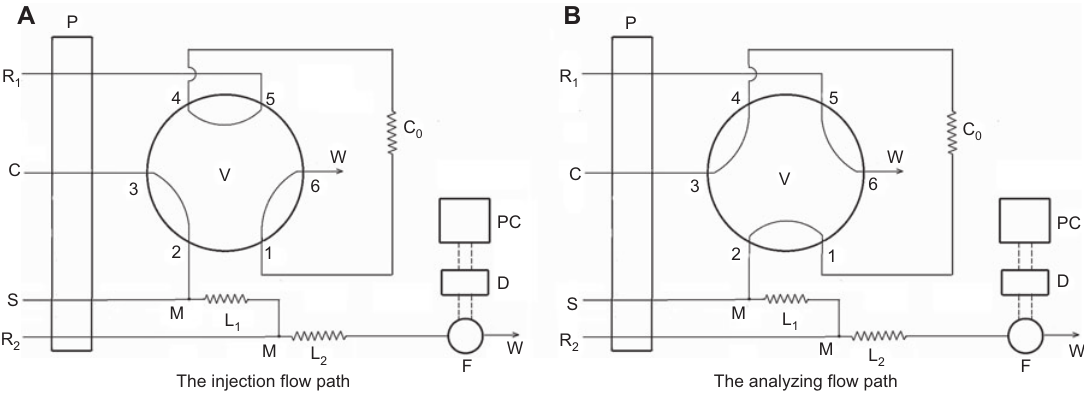
Figure 1 Schematic diagram of the rFIA system.